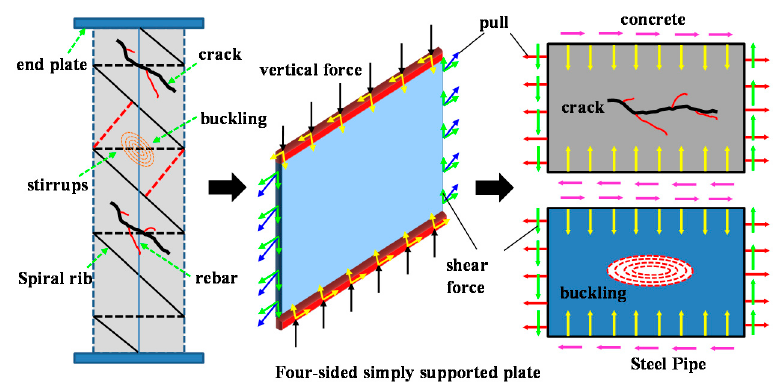
Figure 15. Stress model of specimen